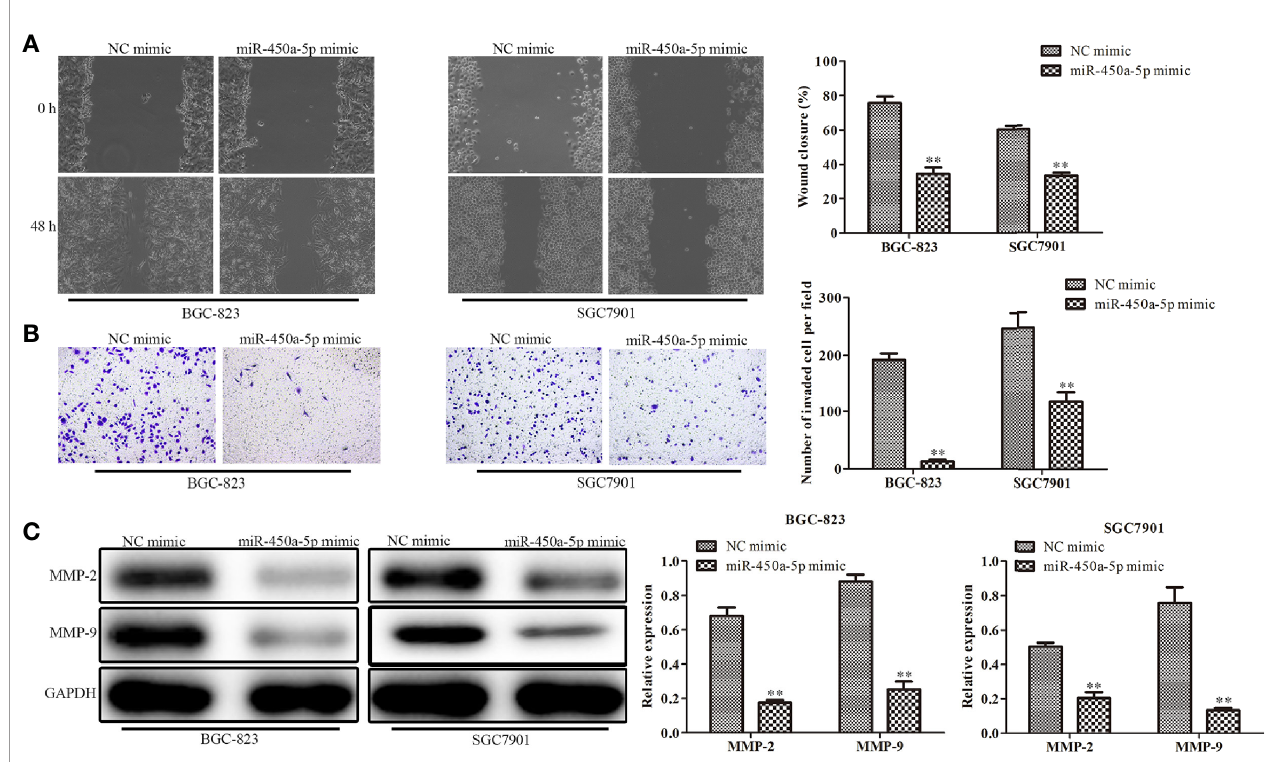
FIGURE 3 | Overexpression of miR-450a-5p inhibits gastric cancer cell migration and invasion. (A) Wound healing assay on the cell migration capability of BGC-823 and SGC-7901 gastric cancer cells after transfection of miR-450a-5p mimic. (B) Transwell chamber assay on the cell invasion capability of BGC-823 and SGC-7901